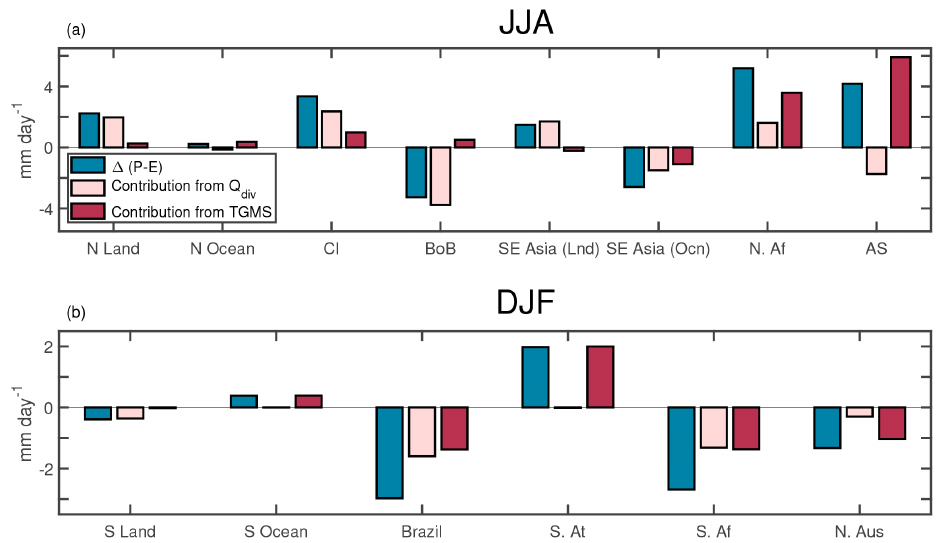
Figure 6. The contribution of Q div and TGMS to the changes in P − E . (a) is for the JJA mean and regions in the Northern Hemisphere, while (b) is for regions in the Southern Hemisphere and averaged over DJF. The blue bar is the change in P − E , while pink and red bars represent the contribution from Q div and TGMS. The abbreviations used in (a) are N Land : northern tropics (land only), N Ocean : northern tropics (ocean only), CI : central India, BoB : the Bay of Bengal, SE Asia (Lnd) : Southeast Asia (land only), SE Asia (Ocn) : Southeast Asia (ocean only), N. Af : northern Africa, and AS : Arabian Sea, and in (b) , S Land : southern tropics (land only), S Ocean : southern tropics (ocean only), S. At : South Atlantic, S. Af : South Africa, and N. Aus : northern Australia. The coordinates of these regions are provided in Table